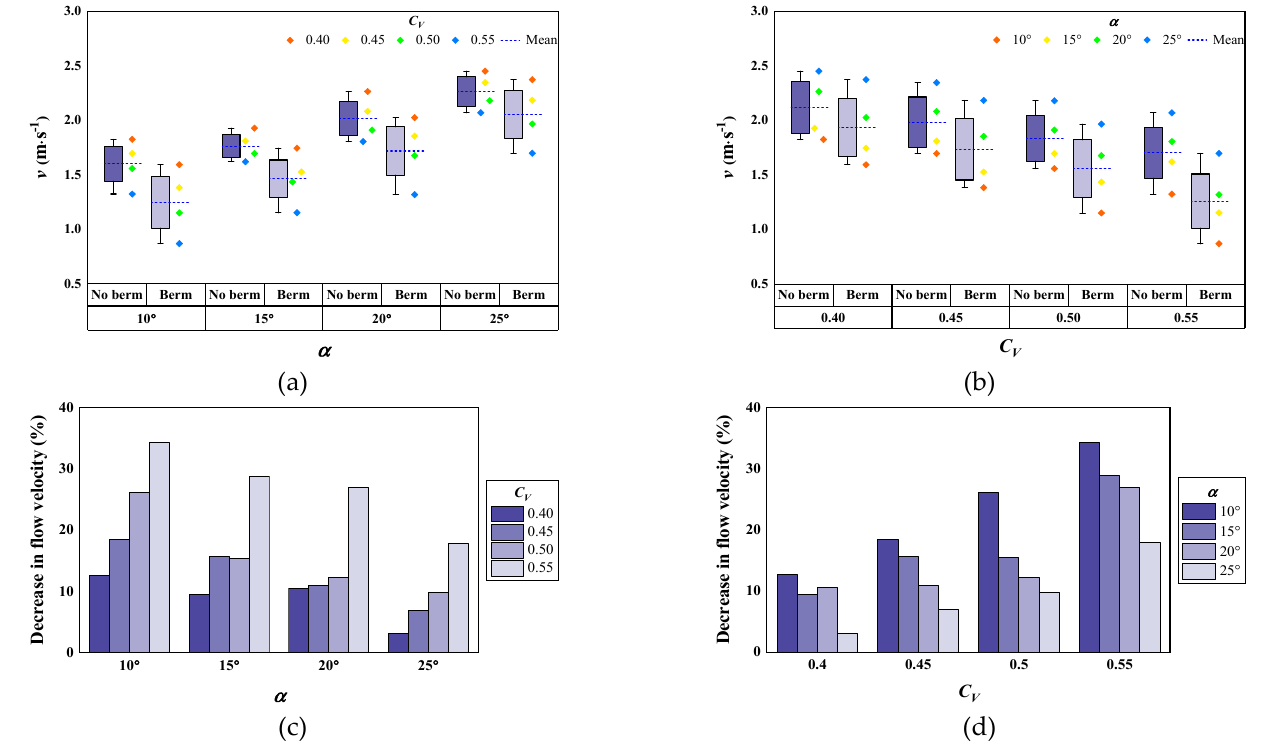
Figure 6. ( a ) Flow velocity according to α (at C V = 0.40–0.55); ( b ) flow velocity according to C V (at α = 10°–25°); ( c ) percent decrease in flow velocity due to berm according to α (at C V = 0.40–0.55); ( d ) percent decrease in flow velocity due to berm according to C V (at α = 10°–25°).